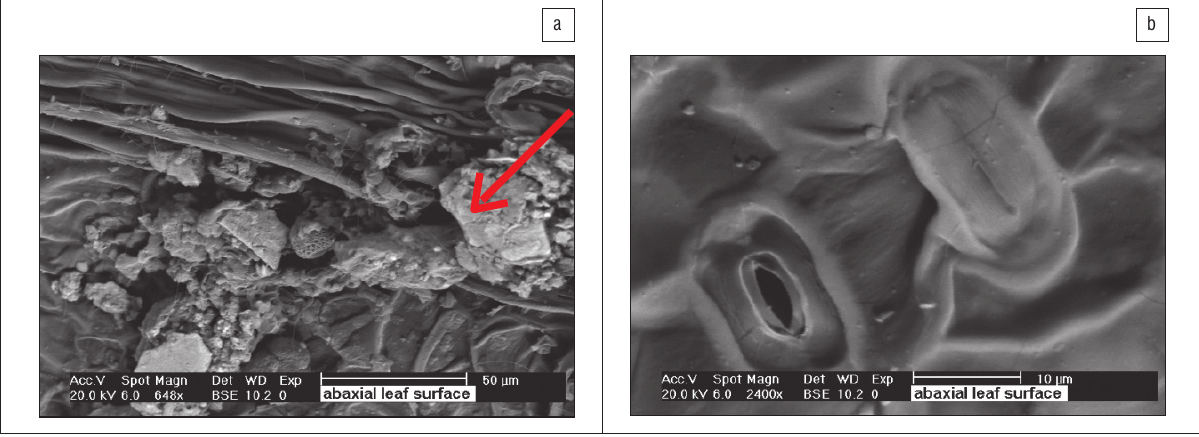
Figure 2: Presence of pollutants around the stomata of leaves collected for a study conducted in Belgrade, Serbia. 25 at (a) 648X magnification and (b) at 2400X magnification. The stomata are the bean-shaped structures and the arrow is pointing to pollutants around